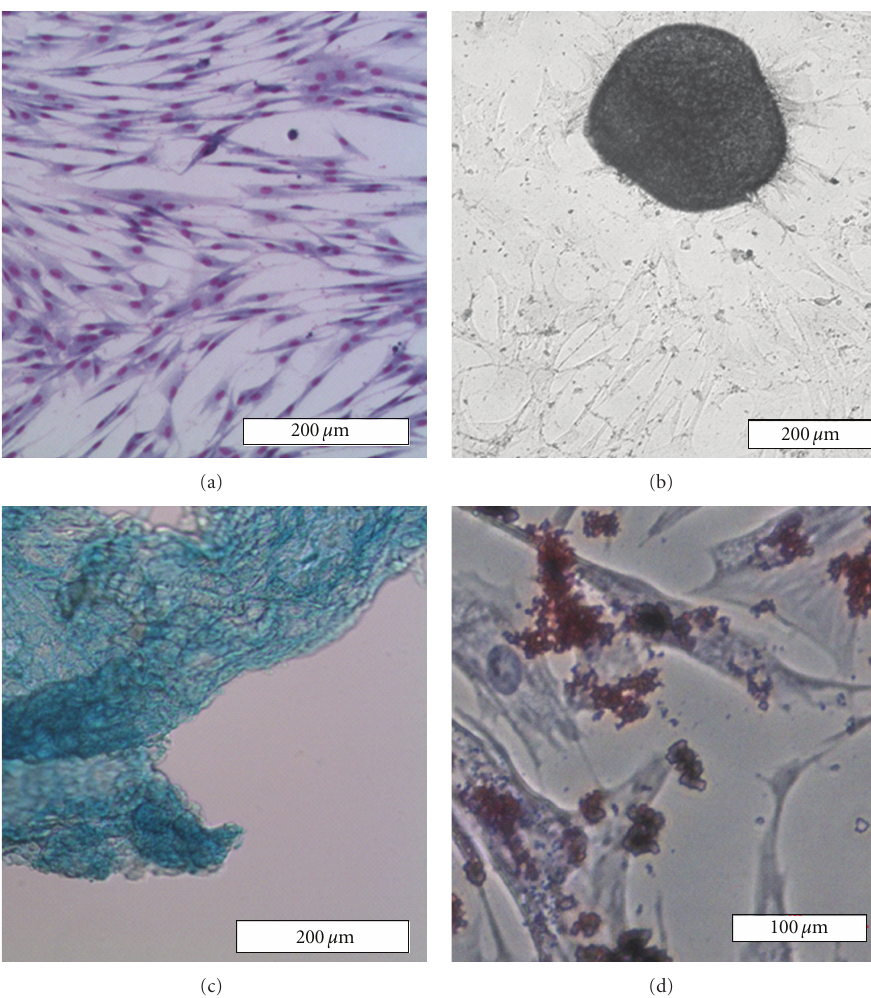
Figure 1: Example of Di ff -Quik stained undi ff erentiated cASCs with flattened fibroblast-like morphology (a). After 5 weeks of osteogenic induction, von Kossa staining was positive, showing large black calcifying nodules (b). Chondrogenic di ff erentiated cASCs show polygonal morphology after 21 days of induction in addition to positive Alcian blue staining of the chondrocyte-specific glycosaminoglycans (c). In (c) an adherent double cell layer is to be seen. Adipogenic induction could be shown 23 days after induction by positive red lipid droplets after Oil Red O staining (d). Scale bar: 200 μ m (a–c) and 100 μ m (d). chondrogenic (Figure 1(c)), and adipogenic (Figure